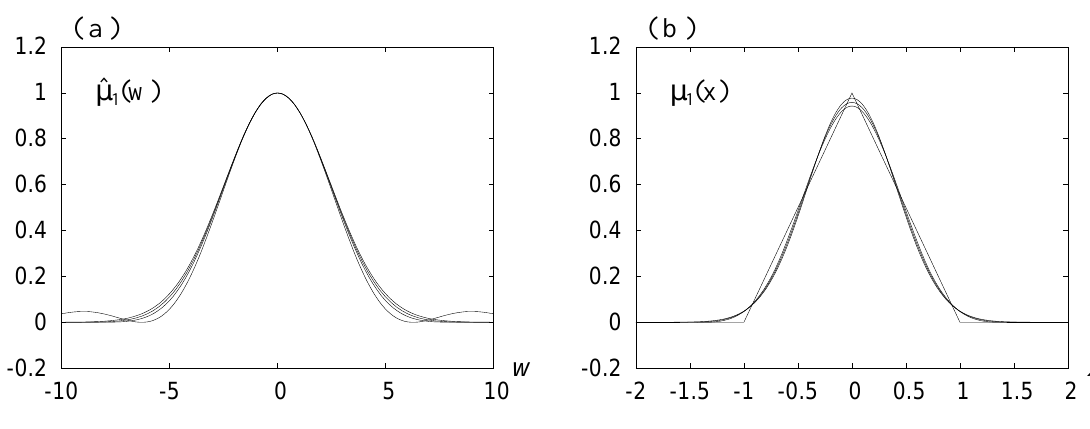
( w ) and µ ( x ) for the mollifiers based on the scaled B-spline wavelets of order Figure 3. ˆ µ 1 1 m = 1 , 2 , 4 , ∞ . The curves take greater values as m increases at w = 5 in ( a ), and at x = 0 . 2 and x = 1 . 2 in ( b